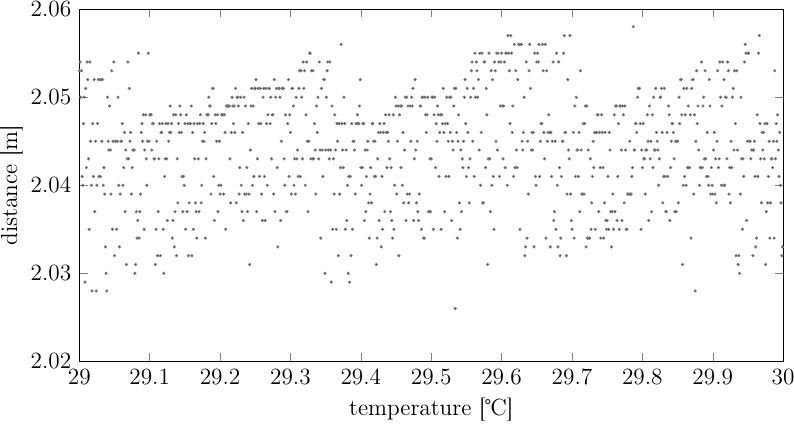
Figure 4. Dependency of the distance measurements on the device temperature for a SICK 200 device pointing to a fixed object in a controlled environment. Despite the true distance and other parameters potentially affecting the measurements being constant in time, the distributions of the measurements are temperature varying. We can notice how the device compensates for the temperature change by adding a temperature-varying negative bias, but that it does not compensate the mode-hopping